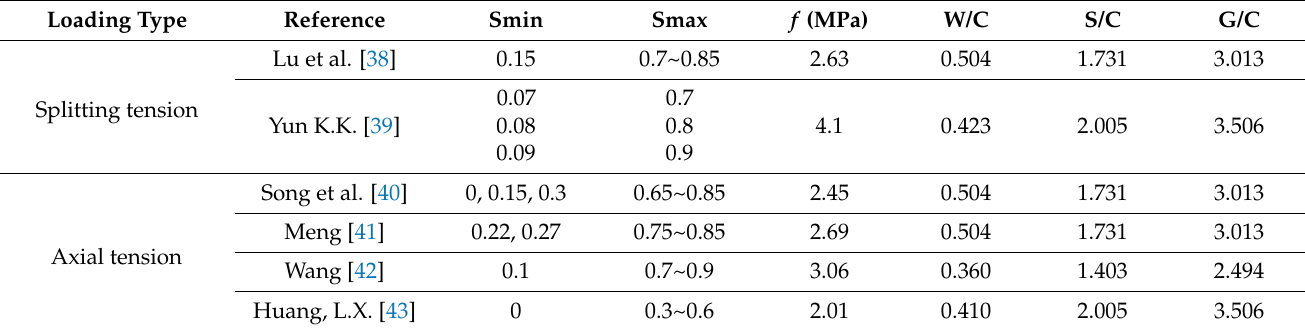
Table 2. Tensile fatigue experimental